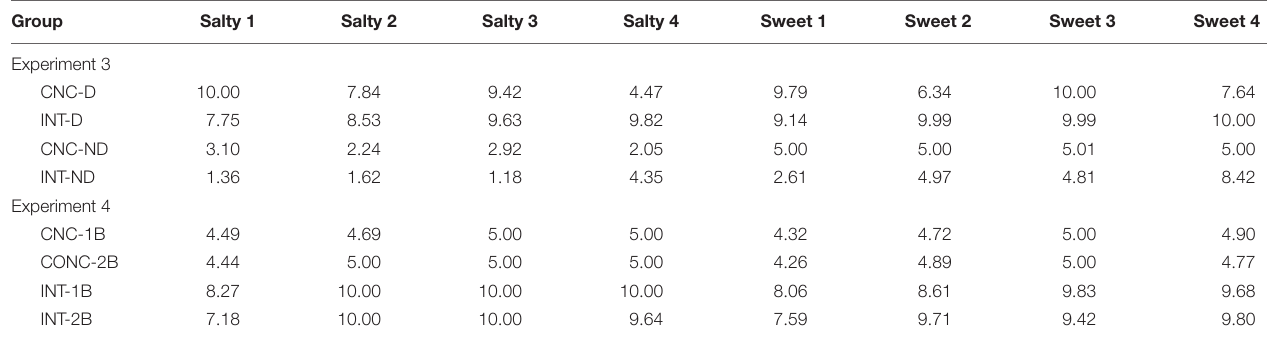
TABLE 1 | Consumption (ml) of the salty and sweet solutions during the pre-exposure trials for all the groups of Experiments 3 and 4.